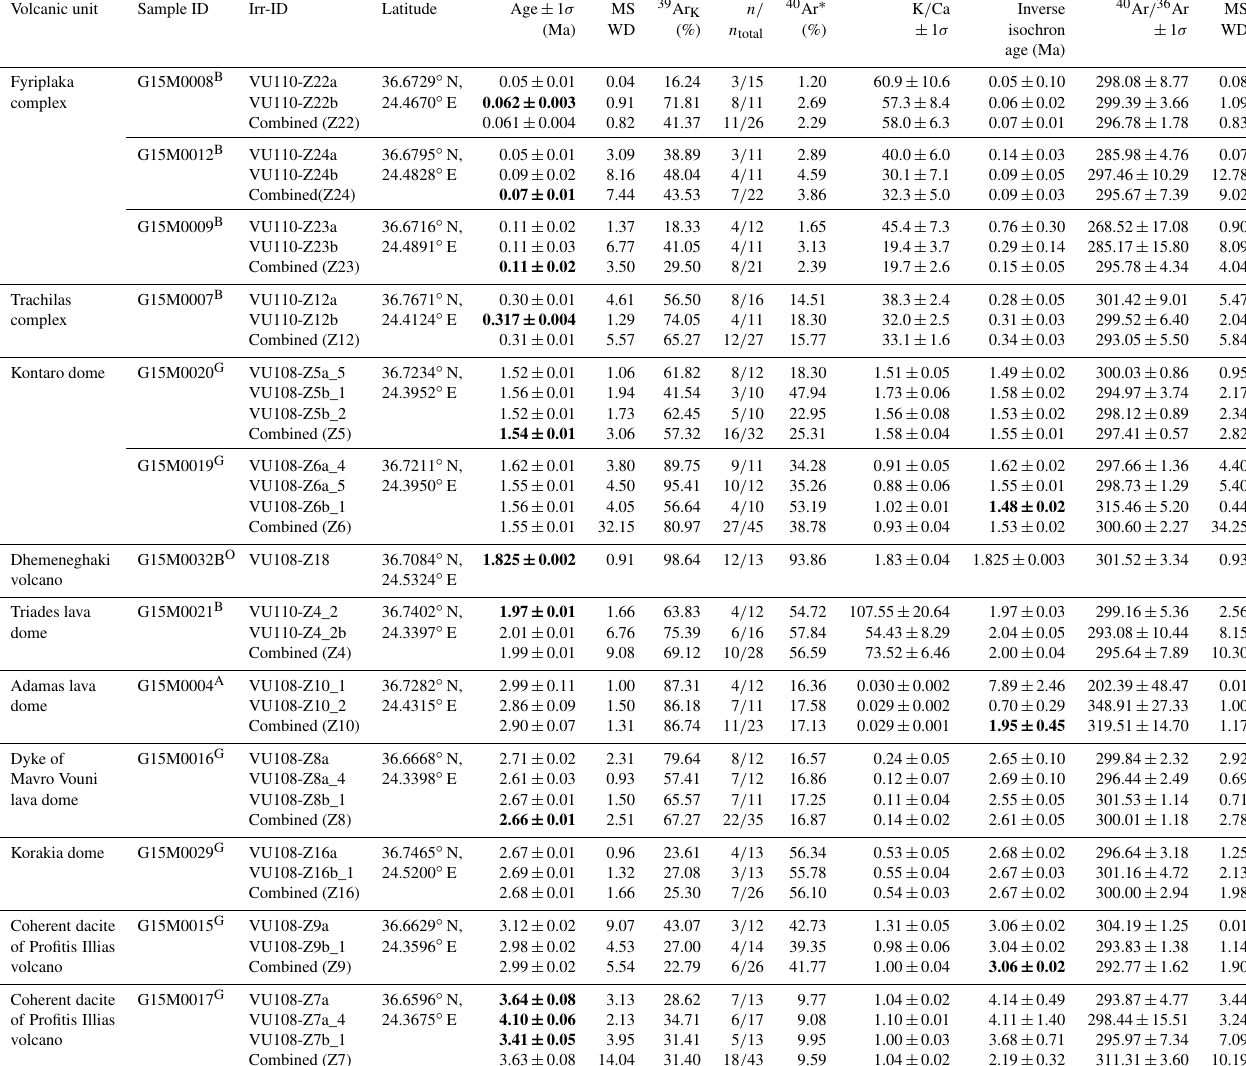
Table 2. Incremental heating 40 Ar / 39 Ar results of the Milos volcanic field. Volcanic unit